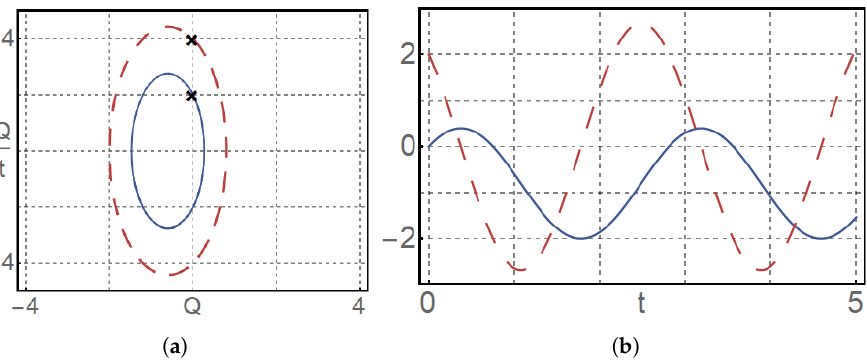
Figure 1. ( a ) Trajectories in the configuration space ( Q , ˙ Q ) for constant-mass ( Γ = 0), with w 0 = 1, Ω = 1.5, and v = 2. The initial conditions are Q ( 0 ) = 0, ˙ Q ( 0 ) = 2 (blue-solid), and Q ( 0 ) = 0, 0 0 ˙ Q ( 0 ) = 4 (red-dashed). The cross indicates the initial conditions. ( b ) The time-dependent functions Q (blue-solid) and ˙ Q (red-dashed) for the initial conditions Q ( 0 ) = 0, ˙ Q ( 0 ) =